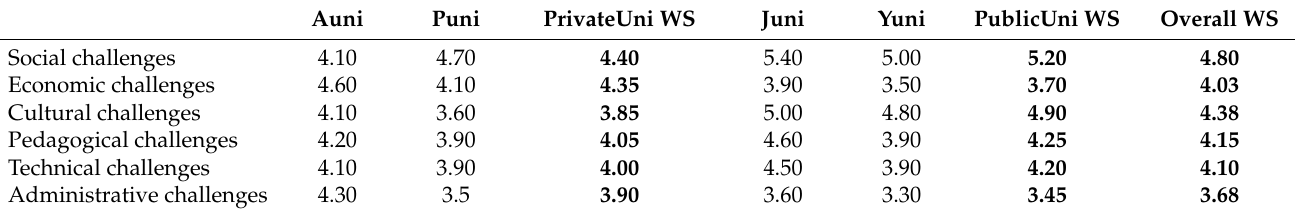
Table 5. Challenges of mobile learning adoption in Jordanian higher education.